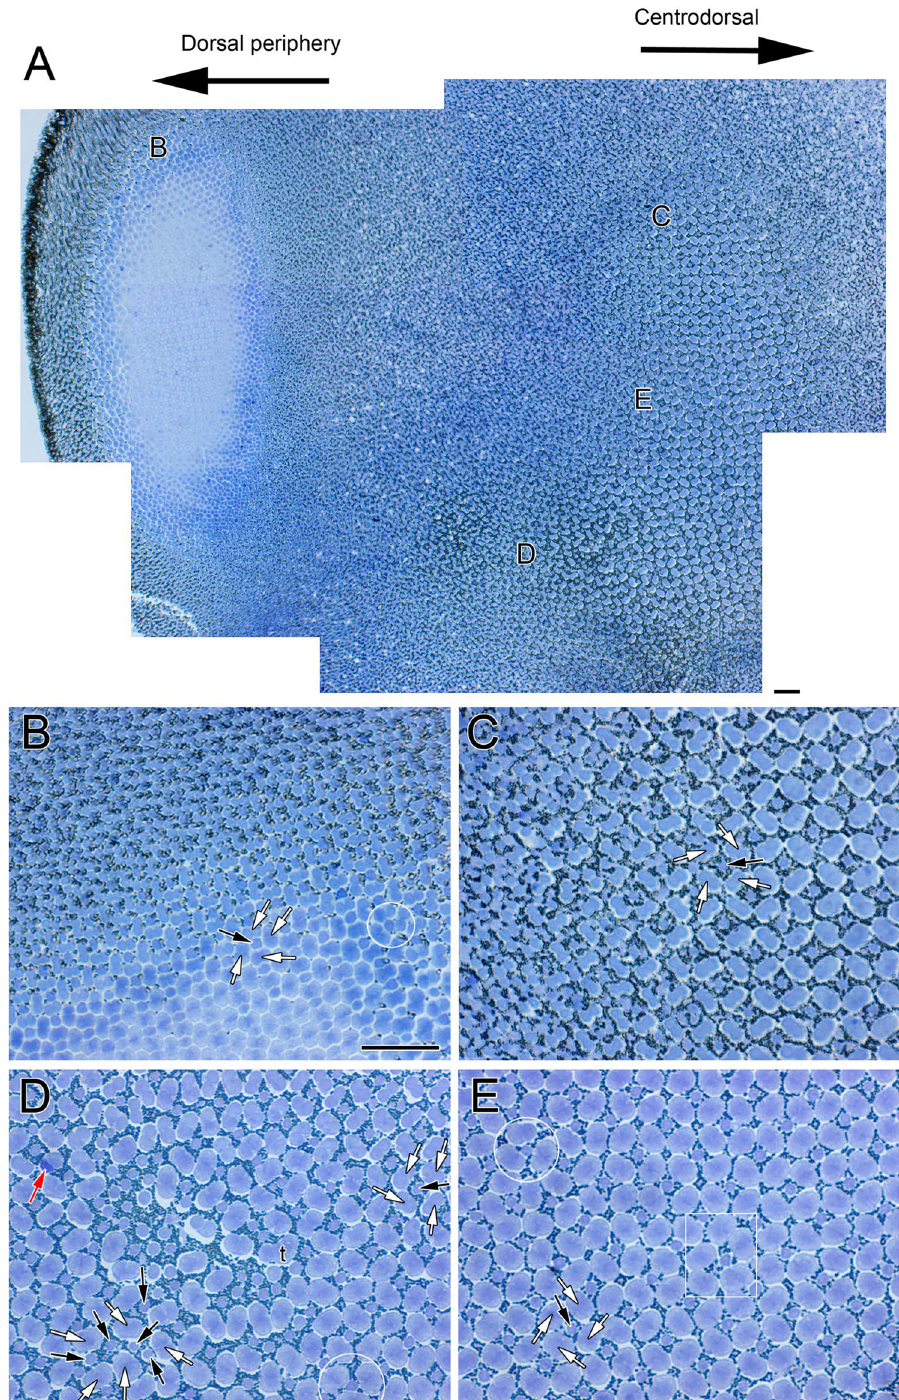
Figure 4. Micrographs of tangential EPON sections showing cone distributions from the dorsonasal retinal quadrant at 878 ATU. ( A ) View stitched together from multiple micrographs spanning the central to peripheral retina. The primary cone formation is a square mosaic but there are other cone arrangements. ( B – E ) Cone distributions from different areas of the field shown in ( A ) and indicated by the same letters (in A ). ( B , D ) White circles encompass a single cone flanked by three double cones. ( E ) The white rectangle shows an area where five double cones surround a single cone. Other symbols and abbreviations as per Fig. 2. Scale bars in ( A ) and ( B ) equal 10 µm; scale bar in ( B ) holds for ( C - E